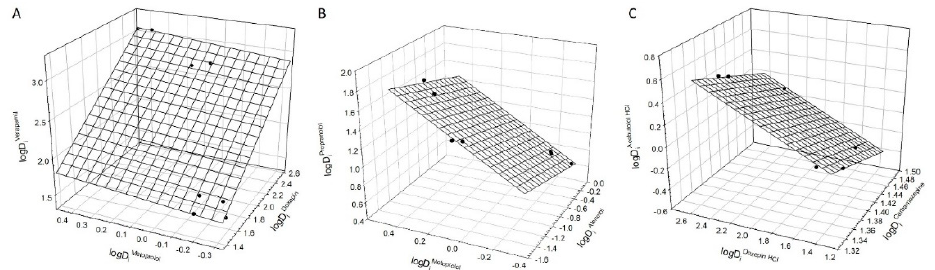
Figure 3. ( A ) Linear relationship between logarithms of distribution coe ffi cients of doxepin, metoprolol, and verapamil in octanol-bu ff er, pH 7.4 with various ionic compositions of the bu ff er (Data from Table S3, Supplementary Information). The plane corresponds to Equation (1). Error bars are the same size as / or smaller than the symbols. ( B ) Linear relationship between logarithms of distribution coe ffi cients of atenolol, metoprolol, and propranolol in octanol-bu ff er, pH 7.4 with various ionic compositions of the bu ff er (Data from Table S3, Supplementary Information). The plane corresponds to Equation (1). Error bars are the same size as / or smaller than the symbols. ( C ) Linear relationship between logarithms of distribution coe ffi cients of carbamazepine, doxepin HCl, and acebutolol HCl in octanol-bu ff er, pH 7.4 with various ionic compositions of the bu ff er (Data from Table S3, Supplementary Information). The plane corresponds to Equation (1). Error bars are the same size as / or smaller than the symbols.